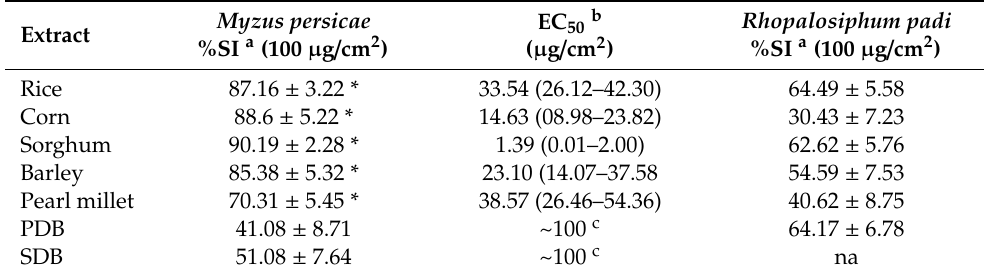
Bioactivity of EFI 671 extracts from di ff erent media against Myzus persicae and Rhopalosiphum padi .